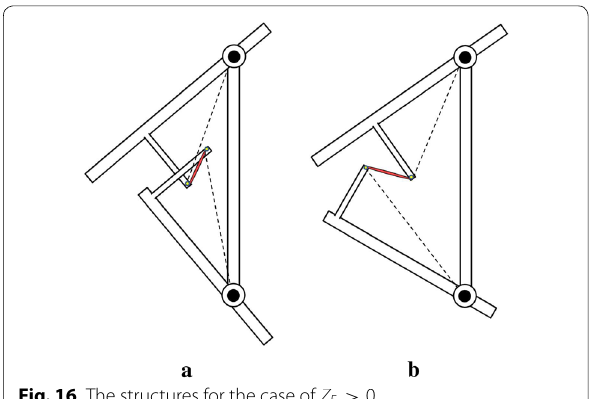
Fig. 16 The structures for the case of Z 5 >